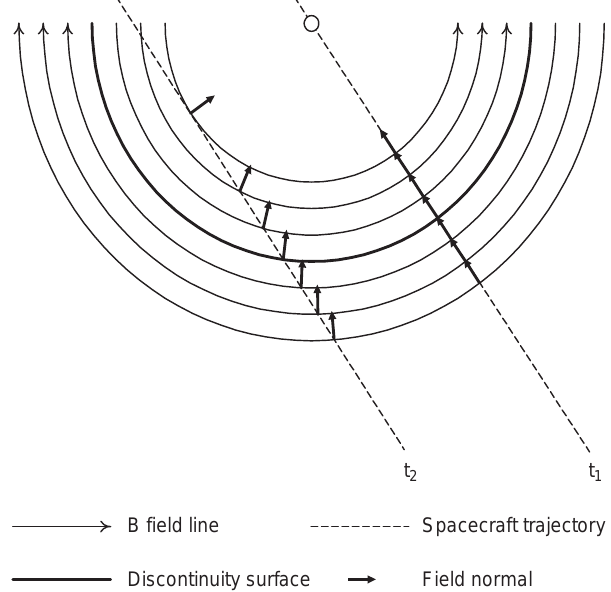
Fig. 3. Diagrammatic illustration of the e(cid:128)ect of thick, curved boundaries on normal determination. Shown is a circular disconti- nuity ( thick curve ), with two spacecraft trajectories ( t normal vectors ( short thick arrows ) to the field lines ( thin curves with arrowheads indicating field direction ) along each trajectory, taken from Dunlop and